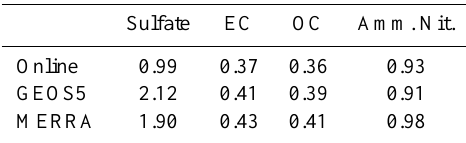
Table 11. Slope of linear fit of annual mean modeled aerosols against IMPROVE data. Sulfate EC OC Amm. Nit. Online 0.99